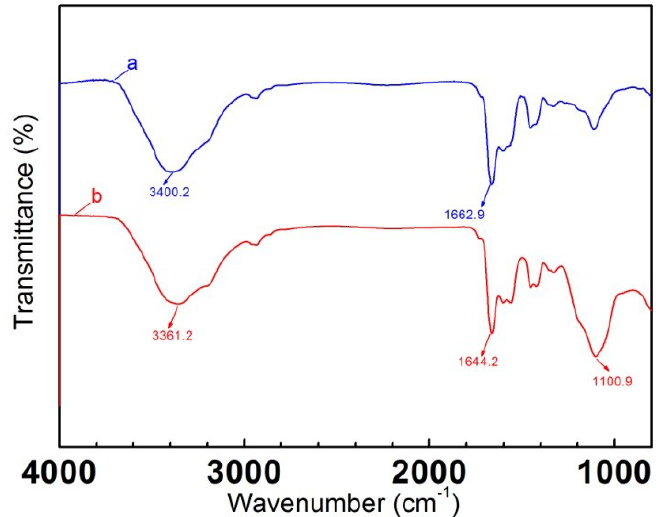
Figure 4. Comparison of FT-IR spectra of ( A ) 0.5% HAHPAM and ( B ) 0.5% HAHPAM/0.5%